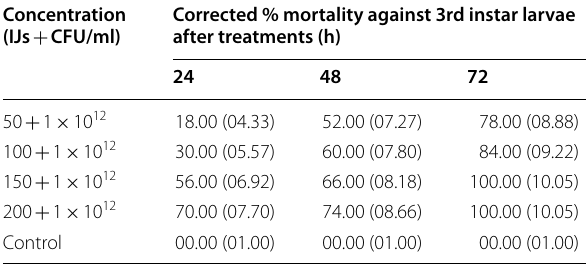
Figures in parentheses are transformed values (arc sine transformation) CD (